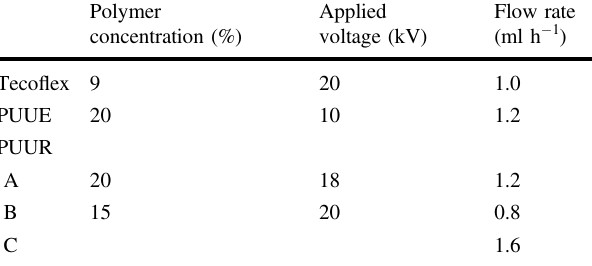
Table 1 Electrospinning parameters to prepare different membranes Polymer concentration (%)